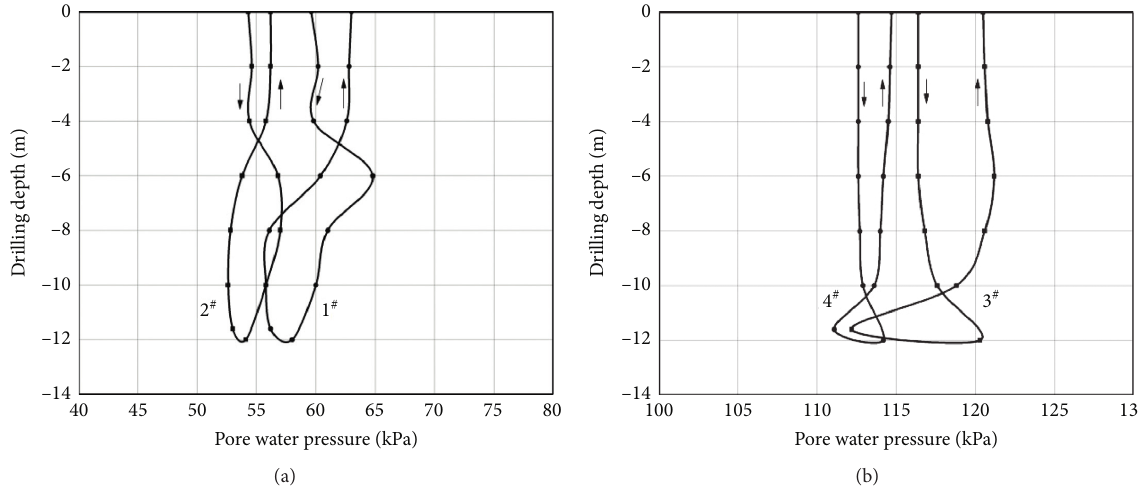
Figure 13: Pore water pressure varies with the drilling depth during the construction of No. 17 pile. (a) 1# and 2# ; (b) 3# and 4#